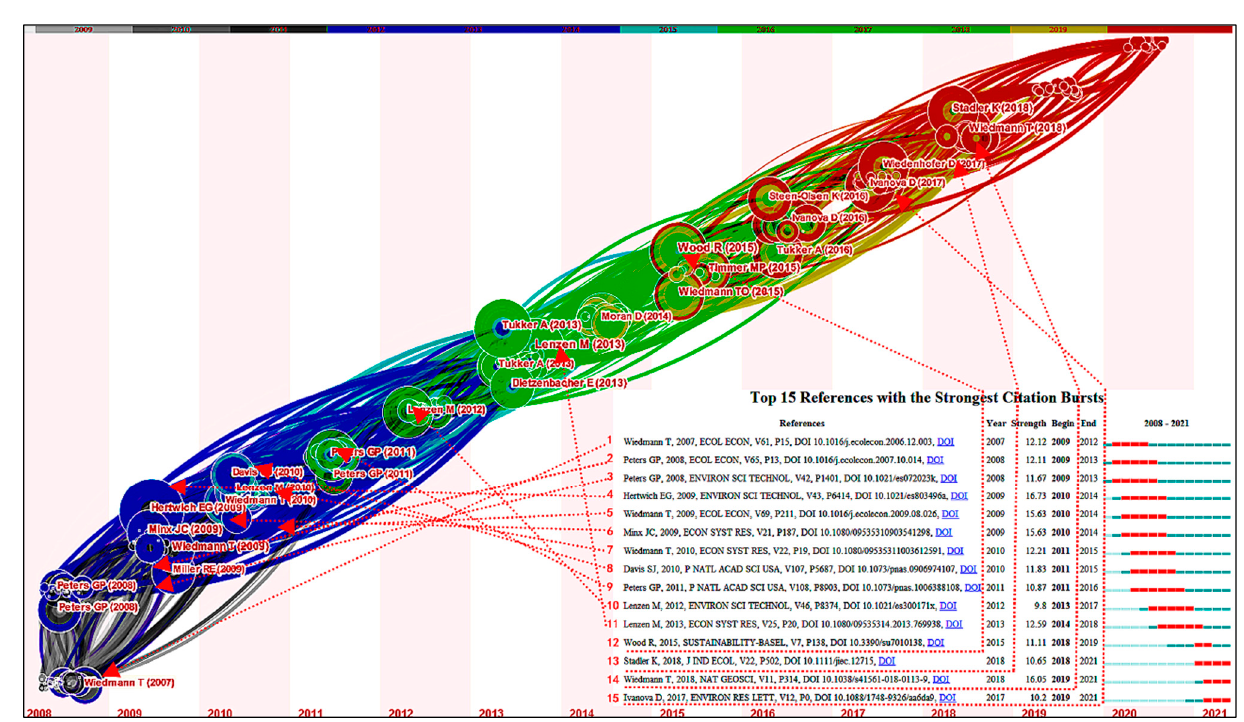
Figure 7. Time-zone view of the cited articles.